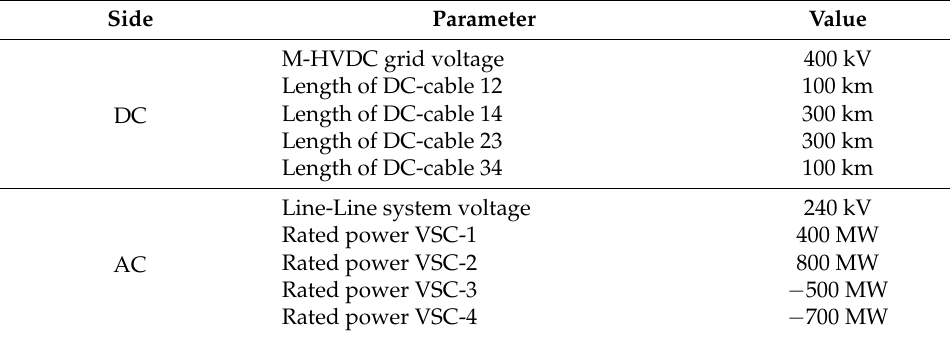
Figure 1. M-HVDC grid system for testing H-DCCB. Table 1. Main Parameters of M-HVDC Test System.